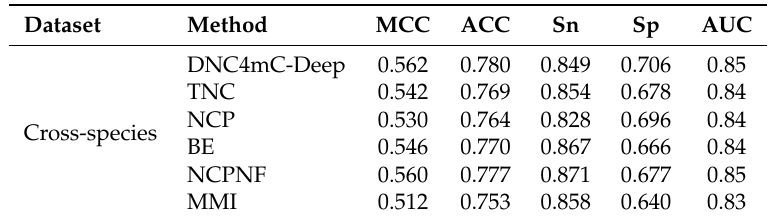
Table 7. Performance evaluation of DNC4mC-Deep and other five encoding methods on independent benchmark dataset for cross-species.